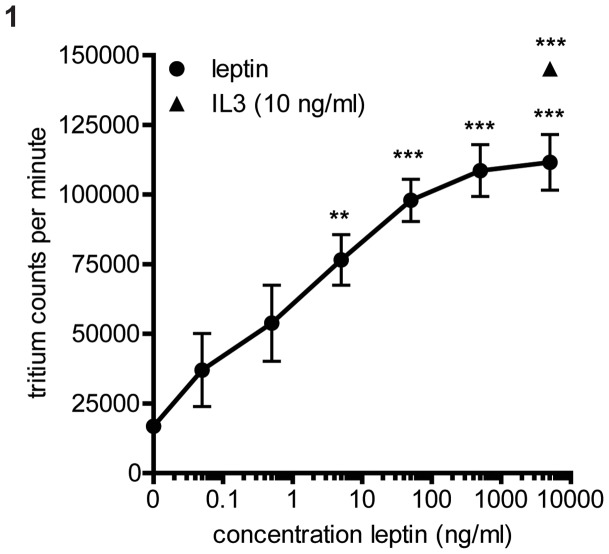
Leptin activity in OBRb Baf3 cells.Proliferation of OBRb Baf3 cells is dependent on leptin or mouse IL3. Baf3 cells were grown in medium supplemented with different concentrations of leptin or positive control IL3 (no leptin was added to the IL3 control) for 48 hours. After four days proliferation was measured by overnight radioactive tritium labeled thymidine incorporation. Graph shows the tritium counts per minute, data are expressed as mean ± SEM, n = 4. Statistics done using one-way ANOVA with Bonferroni posttest comparing leptin stimulated to control (0 ng/ml leptin), *P = <0.05, **P = <0.01, ***P = <0.001.